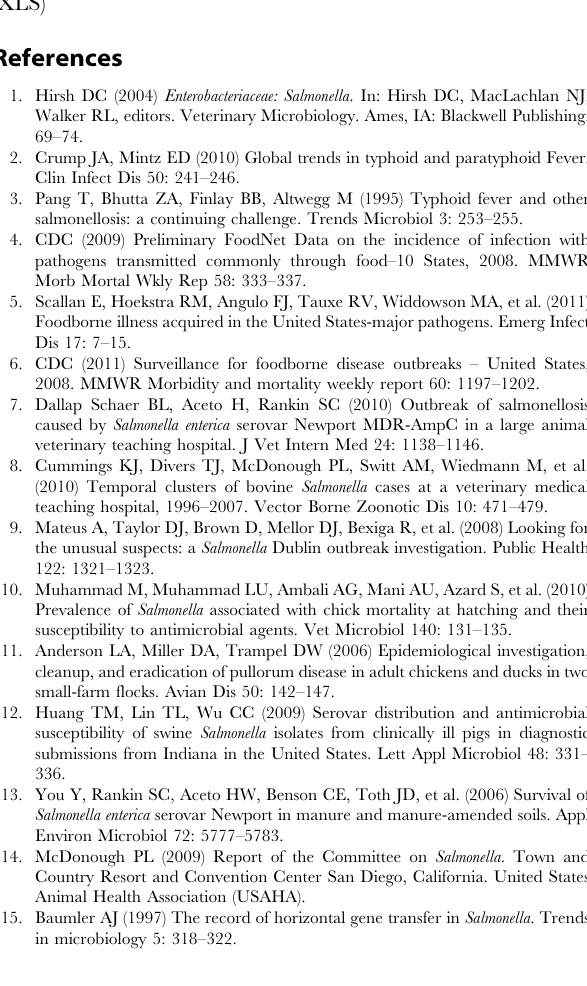
Table S5 List of Salmonella strains that provided genomic or plasmid sequence information. Table S6 Gene loci for all the genes in all the Salmonella FGCs of the genomic data. Table S7 GenBank accession numbers for Salmonella fimbrial adhesin genes that were not from genomic